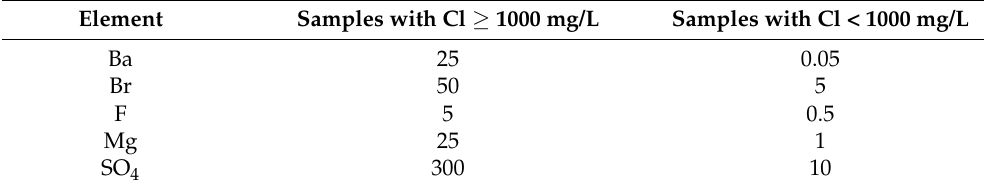
Table 3. Maximum detection limits used in the imputation of censored data. All results in units of